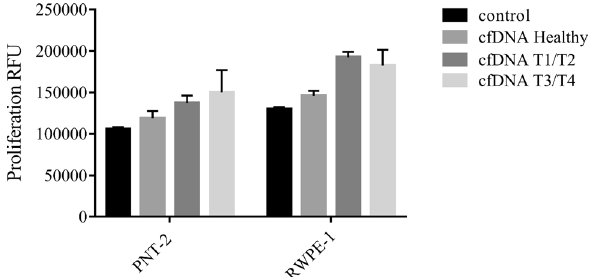
Figure 6. Evaluation of the influence of cfDNA treatment on proliferation. PNT-2 and RWPE-1 cell lines were treated with cfDNA healthy, cfDNA T1/T2, and cfDNA T3/T4 . Twenty nanograms of cfDNA were incubated with 1 × 10 4 cells for 24 h. The proliferation was measured by relative fluorescence units. Data are expressed as the mean ± SEM of at least three independent experiments. No statistical differences were observed (*p < 0. 05; Kruskal–Wallis